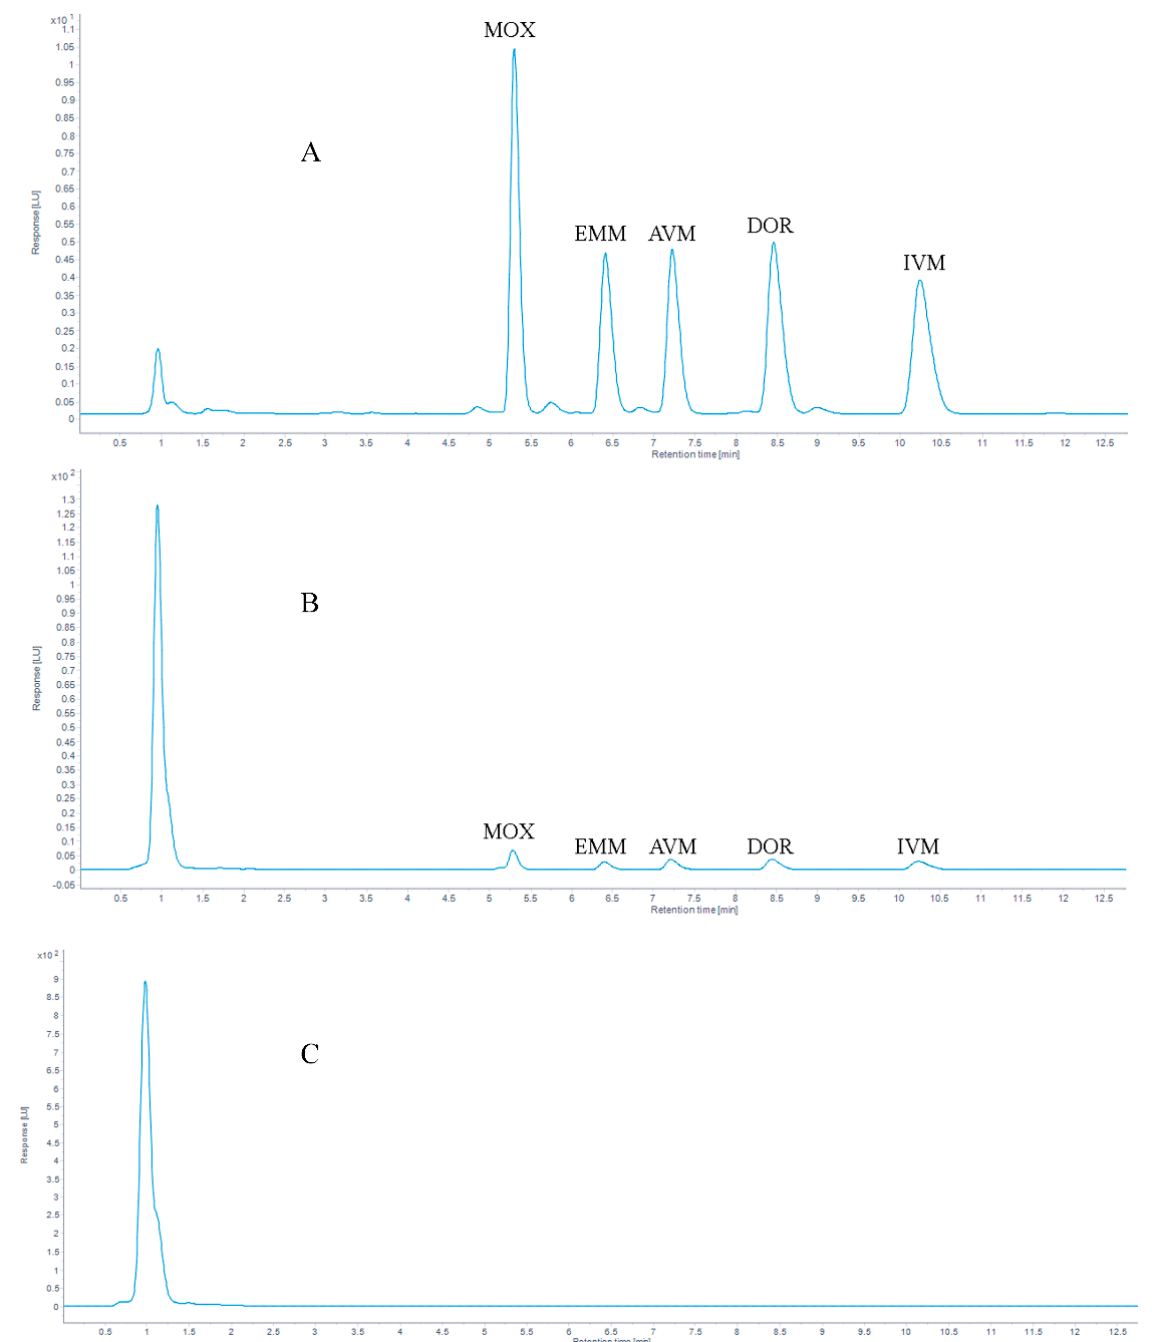
Figure 5. Chromatograms of ( A ) 100 μ g/kg five AVMs standards, ( B ) 10 μ g/kg five AVMs standards spiked in a grass carp muscle sample and ( C ) a blank grass carp muscle sample.